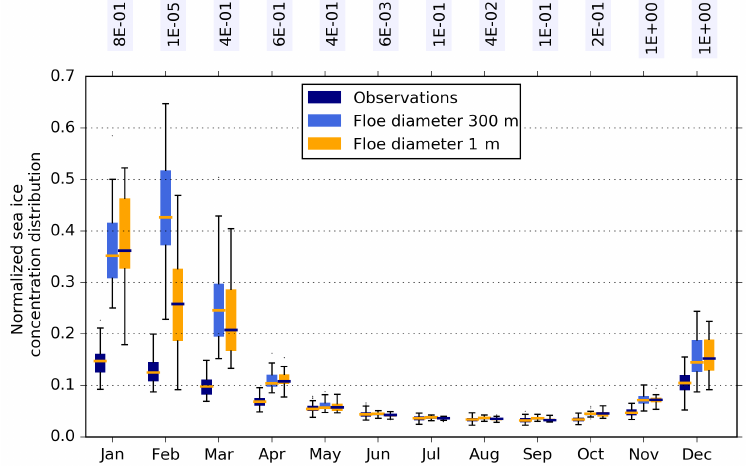
Figure 8. The 10–20% bin from the normalized sea ice concentration distribution for each month, where boxes contain all years from 1992 to 2014 from a NEMO-CICE simulation with (blue) the three sets of satellite observations, (light blue) a floe diameter of 300m (the standard model), and (orange) a floe diameter of 1m. Box plots as in Fig. 1. Annotated text is the p value calculated from a Kolmogorov–Smirnov test, which represents the confidence that the two populations come from the same distribution.